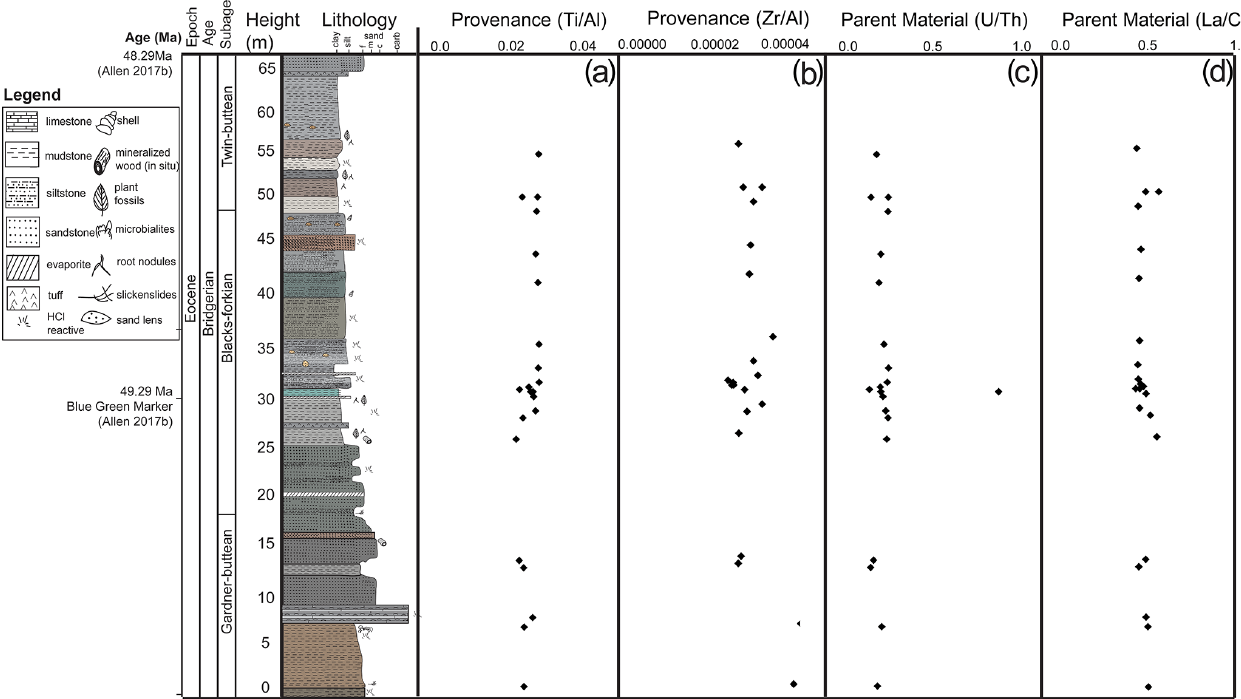
Figure 5. Stratigraphy with parent material and provenance proxies. (a) Provenance using molar ratios of Ti / Al, (b) provenance using molar ratios of Zr / Al, (c) parent material using molar ratios of U / Th, and (d) parent material using molar ratios of La /